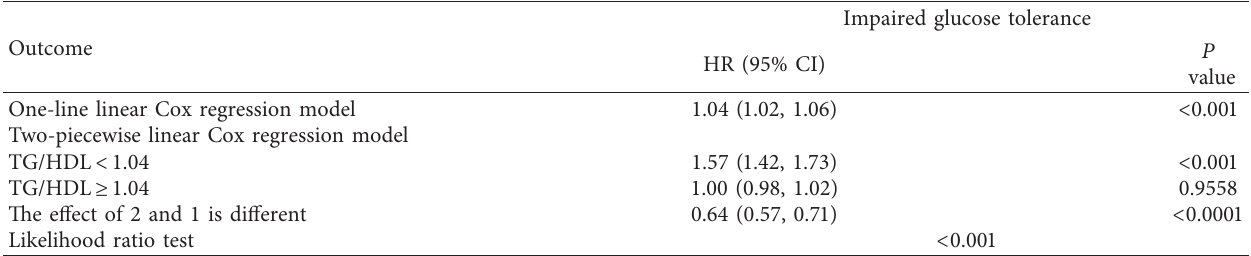
Table 3: Threshold effect analysis of TG/HDL on incident impaired glucose tolerance.